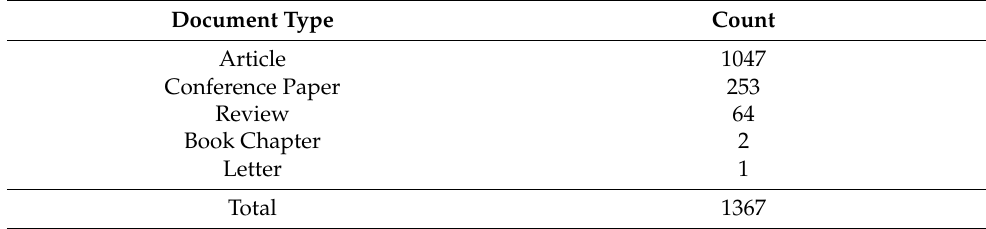
Table 1. Distribution of Document Types for Bibliometric